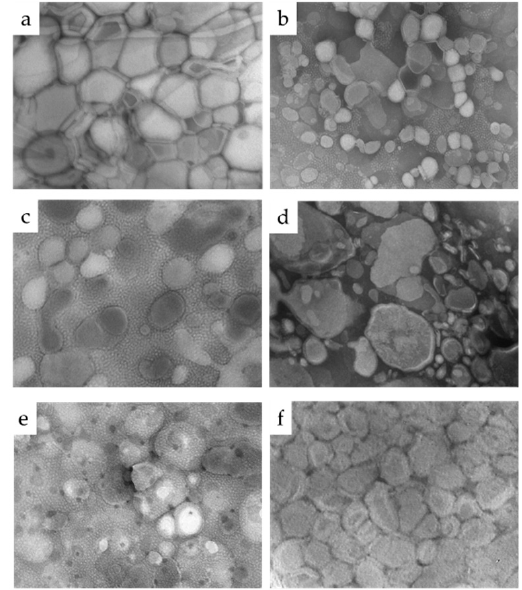
Figure 2. Transmission electron microscopy images (TEM) of P7 ( a ), P9 ( b ), P11 ( c ), P12 ( d ), P13 ( e ), and P16 ( f ). Bar corresponds to 200 nm ( a , c , d ) or 500 nm ( b , e , f ).